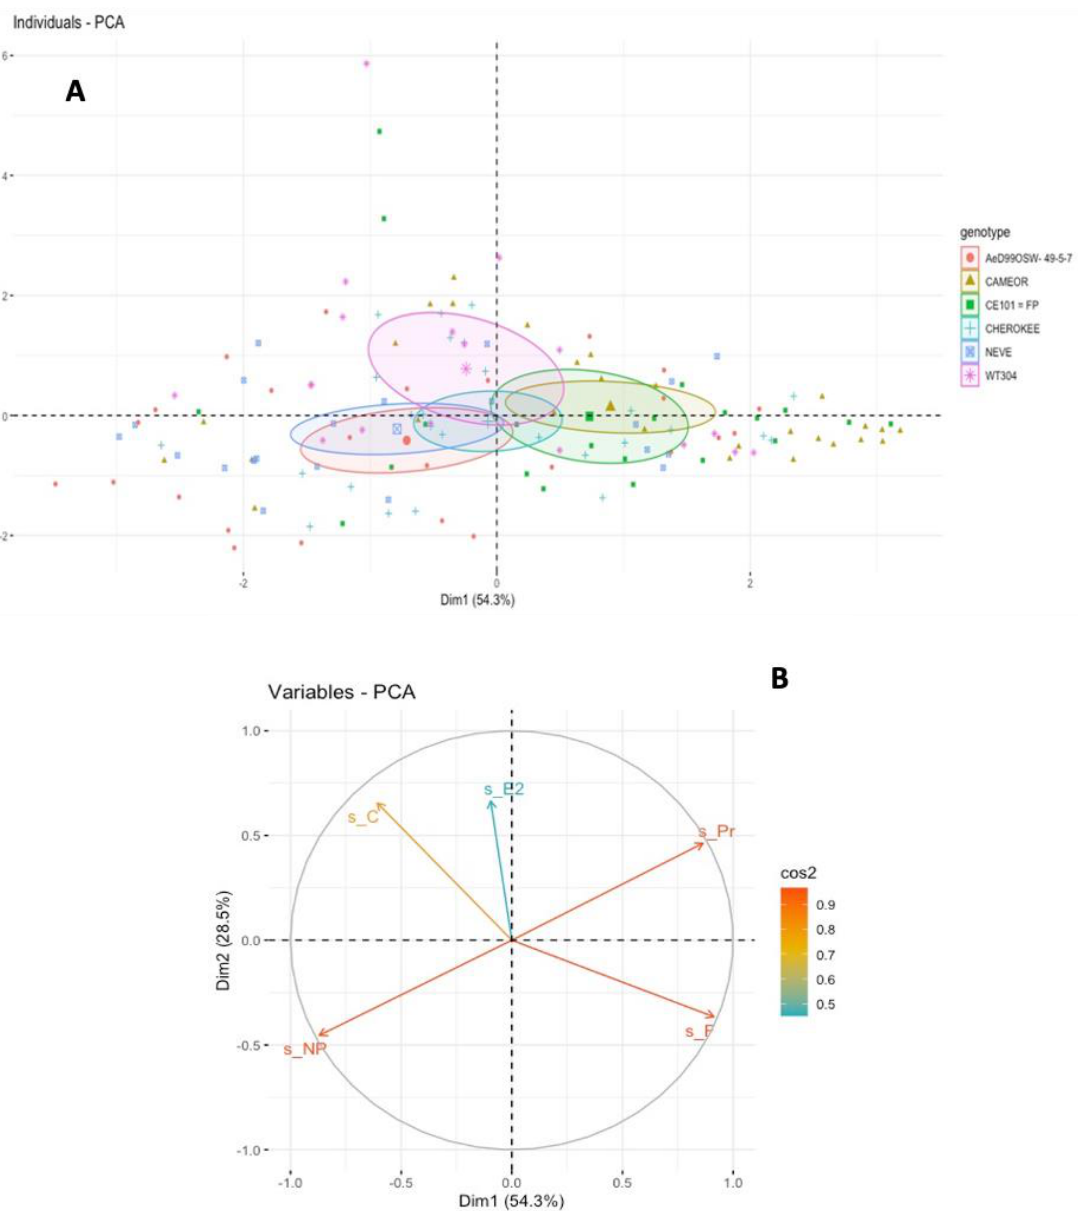
Figure 4. Principal component analysis (PCA) for the aphid trophic behavior by EPG study. Indi- viduals factor map indicating the scores of aphids A. pisum feeding on six Pisum genotypes. The circles show the confidence ellipses (with a confidence level of 0.95) calculated with the barycenter of individuals for each parameter on the factorial plan. ( A ) PCA of individuals of alfalfa biotype (LSR1) probing on Pisum genotypes. ( B ) Variables factor map indicates the spatial ordination using five parameters: s_NP, total non-probing duration; s_C, total pathway phase; s_Pr, total probing duration; s_F, total stylets derailment duration; and s_E2, total phloem ingestion duration.